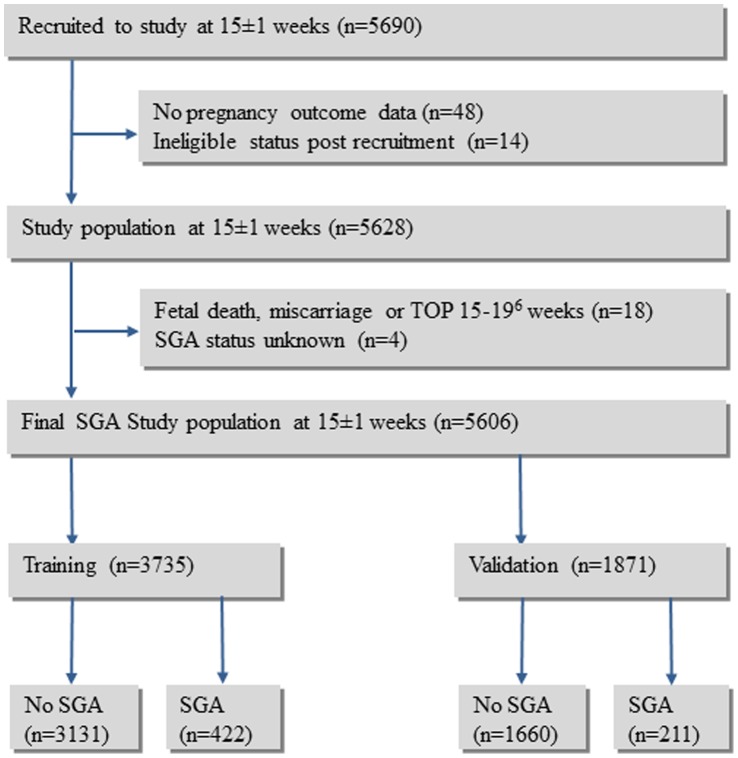
Flow chart of study population.